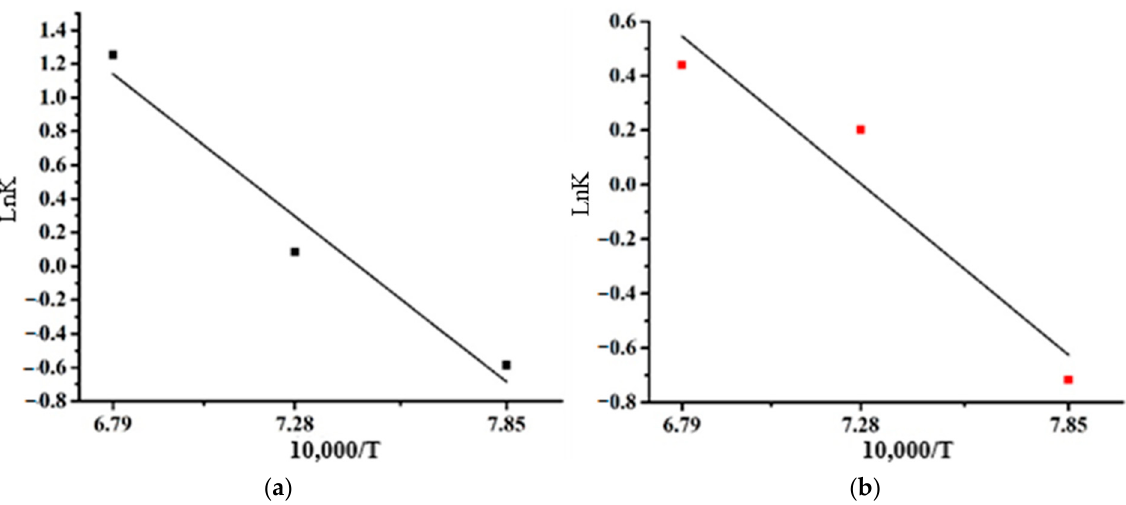
Figure 6. Influence of temperature and reduction time on grain sizes of reduced iron in the D 1/n − t plots for the RM roasting without additives ( a ) and with 13.65% Na 2 SO 4 ( b ). The values of Q G and K 0 can be obtained from the slopes and intercepts of LnK − 1/T plots, respectively. After that, the equations can be obtained for the calculation of the av- erage diameter of iron grains formed during the carbothermic reduction of RM. Figure 7 shows LnK − 1/T plots for both the carbothermic roasting RM without additives and with Na 2 SO 4 .